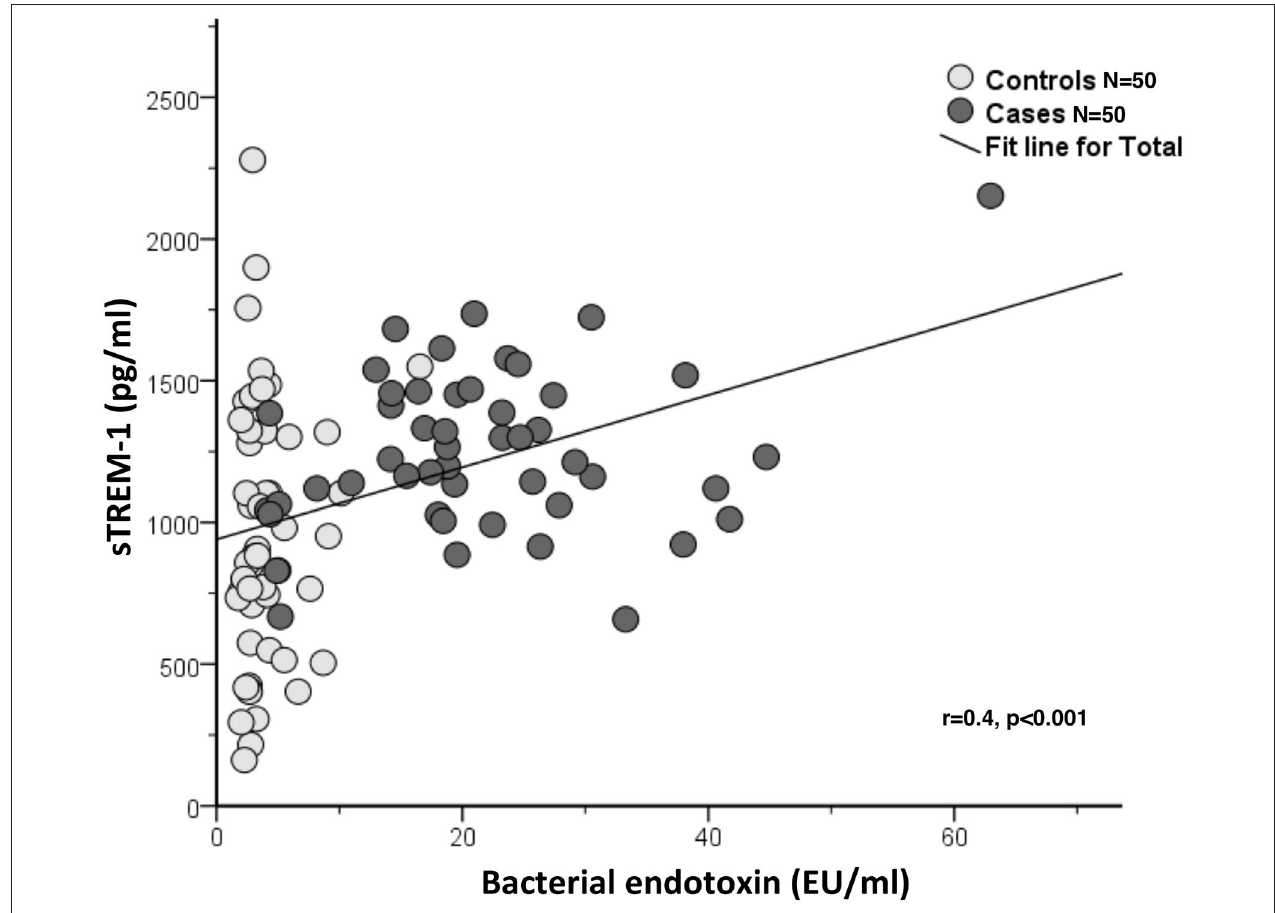
FIGURE 2 | Correlation between sTREM-1 (pg/ml) and bacterial endotoxin (EU/ml) in the case-control study (one time point) ( N = 100).